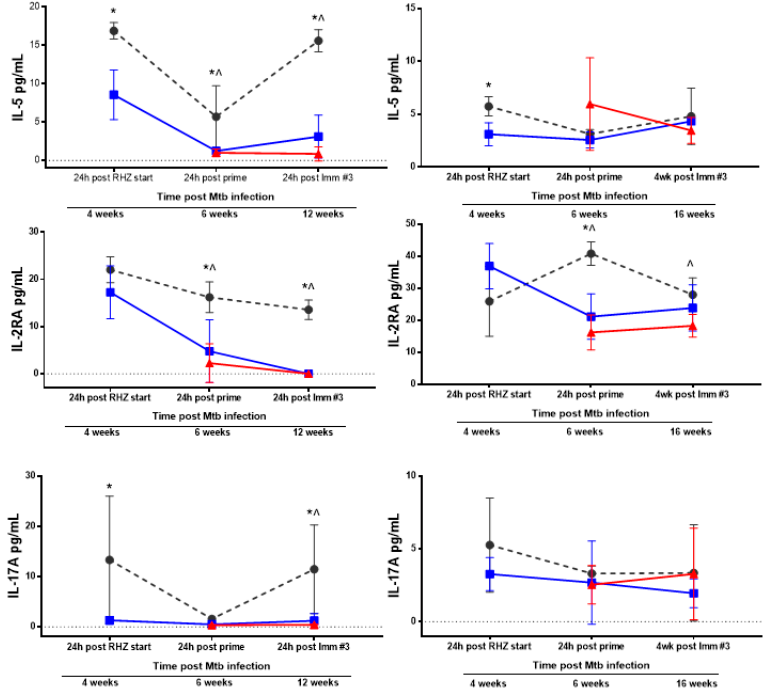
Figure 5. Therapeutic treatment against Mtb leads to reduced BALF and plasma inflammatory cytokines over time. Cytokine and chemokine analysis of BALF ( left ) and plasma ( right ) samples from cohorts of mice that were either untreated (grey, circles), RHZ-treated (blue, squares), or RHZ+ID93/GLA-SE-treated (red, triangles). The data represents the average value ± SD of four or five individual mice run in duplicate for each time point. Time points examined included 24 h post RHZ initiation, 24 h post prime and either 24 h or three weeks following the final immunization, corresponding to 4, 6, and 12 weeks (BALF) or 4, 6, and 16 weeks (plasma) post Mtb infection. Groups were compared using two-way ANOVA and Sidak’s multiple comparisons test. p < 0.05 difference between groups at a specific time point represented as: * no treatment versus RHZ; ^ no treatment versus RHZ+ID93/GLA-SE; #RHZ versus RHZ+ID93/GLA-SE. 3.4. The Percentage of Regulatory T Cells in the Lung are Not Increased Due to Immunotherapy in the